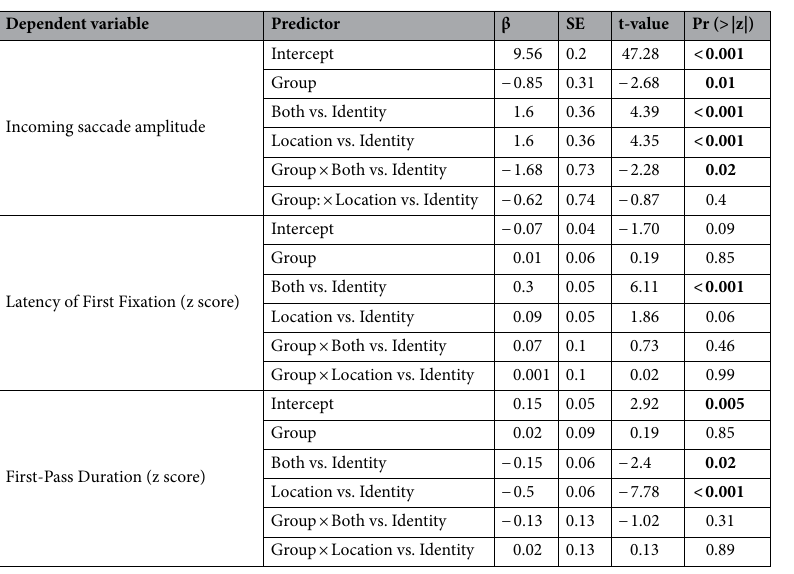
Table 3. Linear mixed effects model output for the eye-tracking measures on the Current Location during recognition (correct trials only): incoming saccade amplitude, latency to first fixation (z-score) and first- pass gaze duration (z-score) on the critical object. Predictors centred and standardized entered were Group (Younger = − 0.5 and Older = 0.5) and Type of Change (Location, Both—Identity as reference level). We report the β , the standard error, the t -value and the p -value. The random effects introduced as intercept were Participants (50) and the unique identifier of Scene item